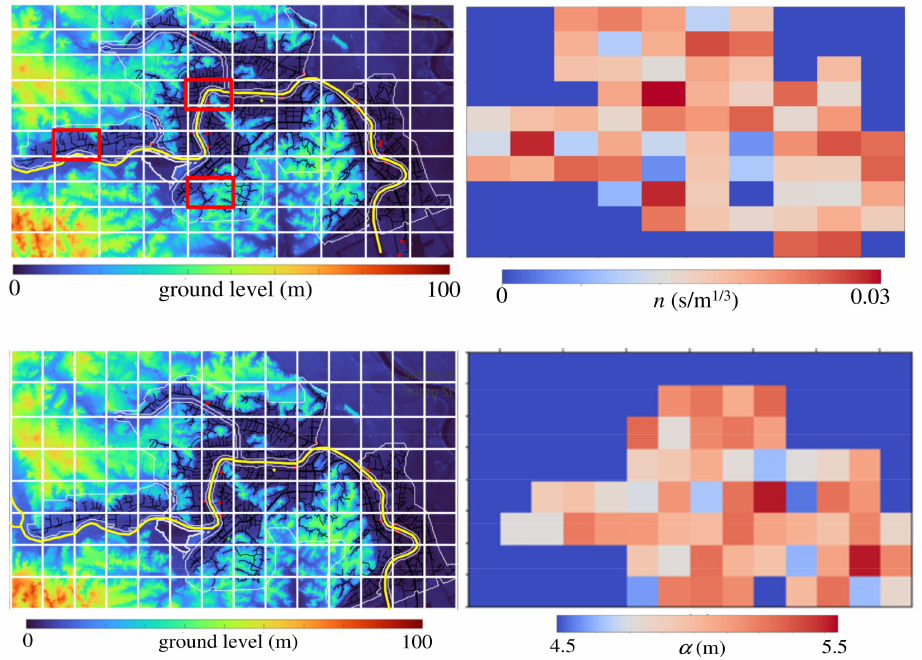
Figure 8. Spatial distribution of the tuned Manning’s roughness ( top ) and the coefficient, α ( bottom